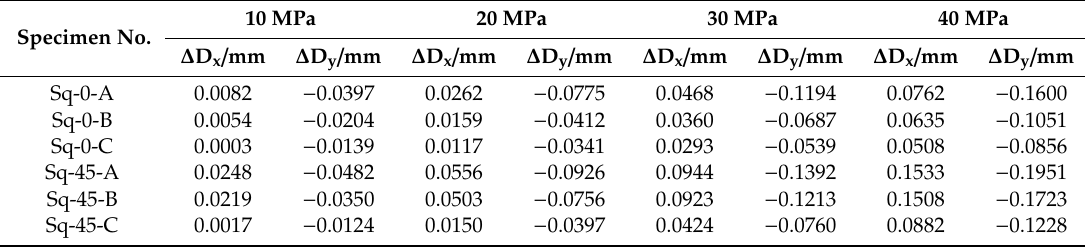
Table 3. Deformation of 0° and 45° hole under different filling modes at stresses of 10–40 MPa. Specimen No.